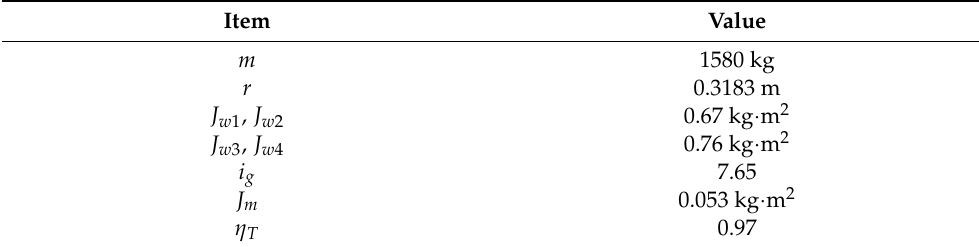
Table 1. Specifications of the test